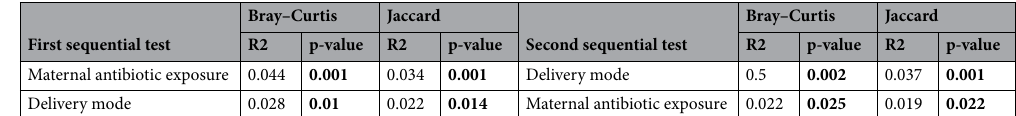
Table 4. Results of the PERMANOVA test using both delivery mode and antibiotic exposure. Both sequential tests were adjusted for DNA extraction batch as first covariate. In the first test, maternal antibiotic exposure was added as covariate prior to delivery mode, while in the second test their order was inverted. Significant values are in